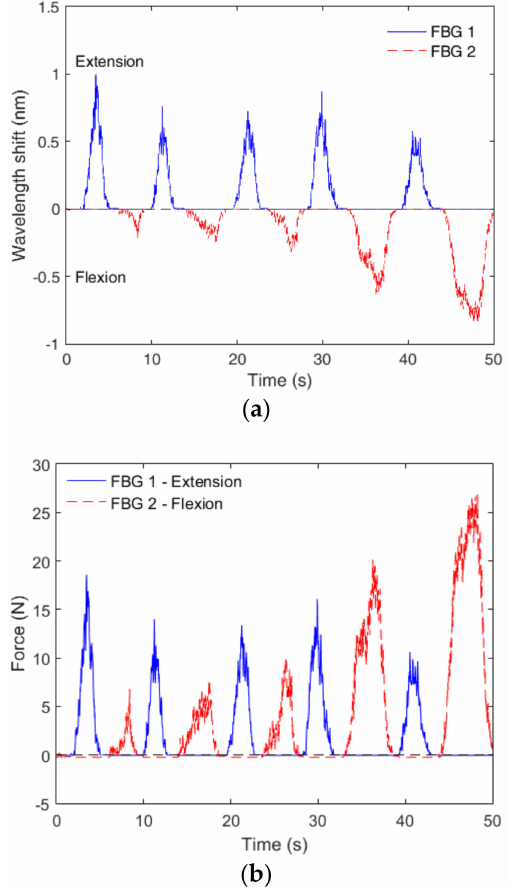
Figure 11. ( a ) Responses of the FBGs embedded in shank support 1 and 2 for extension (FBG 1) and flexion (FBG 2) cycles and ( b ) Human–robot interaction force measurement with the FBG-embedded, 3D-printed flexible